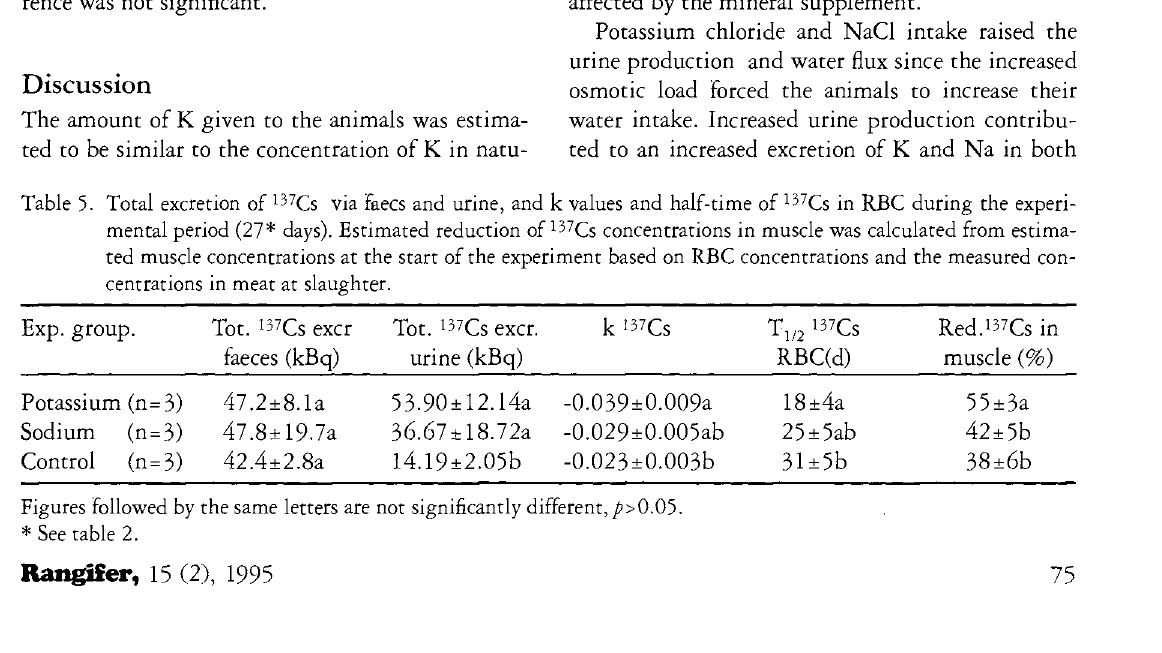
Table 5. Total excretion of 137 Cs via faecs and urine, and k values and half-time of 137 Cs in RBC during the experi mental period (27* days). Estimated reduction of 137 Cs concentrations in muscle was calculated from estima ted muscle concentrations at the start of the experiment based on RBC concentrations and the measured con centrations in meat at